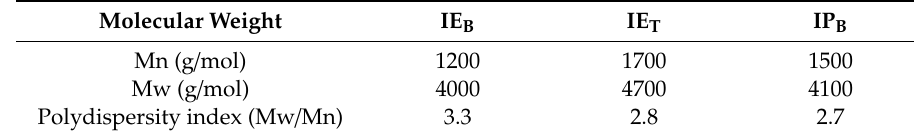
Table 5. Results from Gel Permeation Chromatography (GPC) analysis of E. nitens lignins recovered after delignification treatment for both ionic liquids and the Ionosolv lignin from Pinus pinaster wood ( IP B )